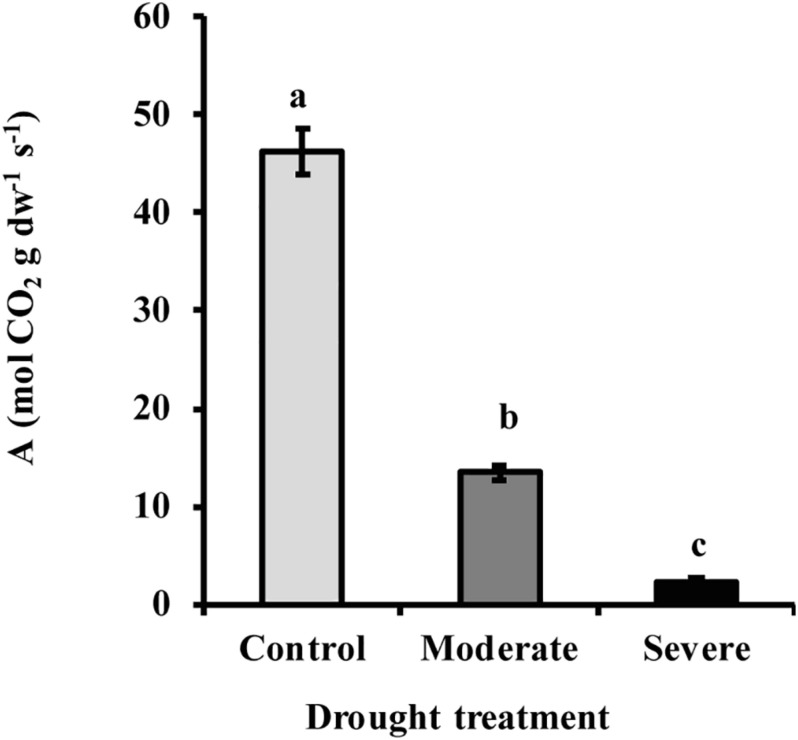
Drought reduced the rate of photosynthesis A in white spruce (Picea glauca). Photosynthesis declined under moderate (transpiration rate 50% of well-watered control) and severe drought treatment (transpiration rate 20% of control). Data shown are means of five biological replicate ± SE. Different letters indicate significant differences at P < 0.05.